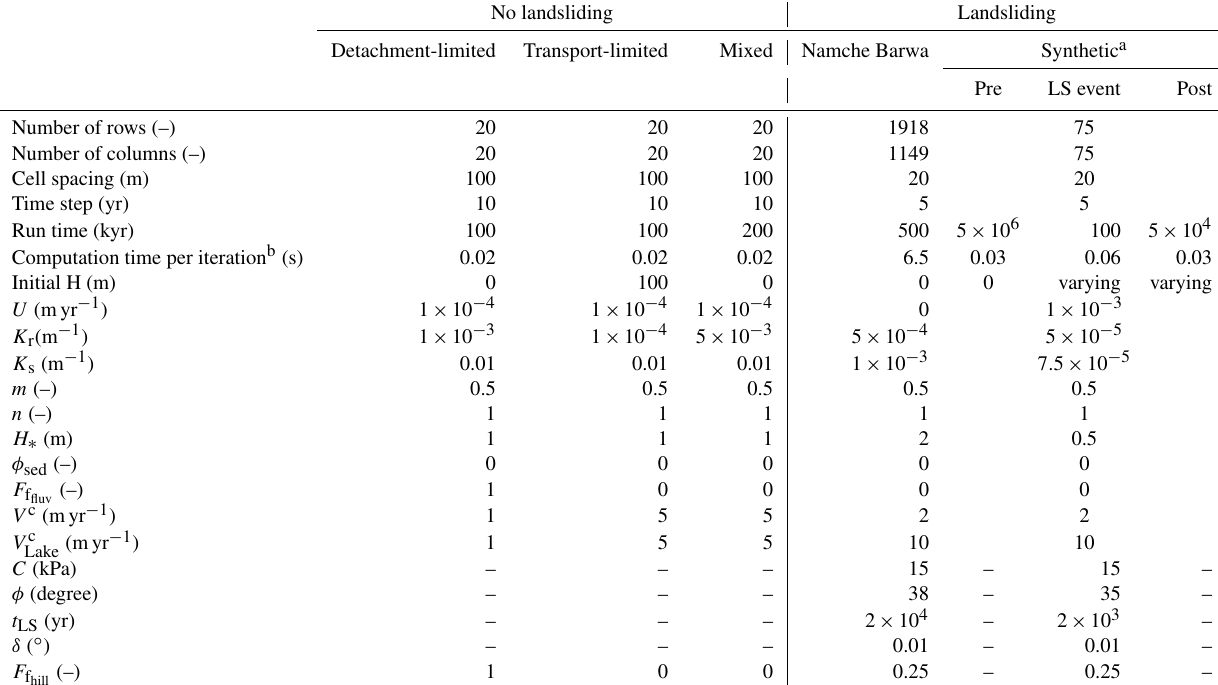
Table 1. Parameter